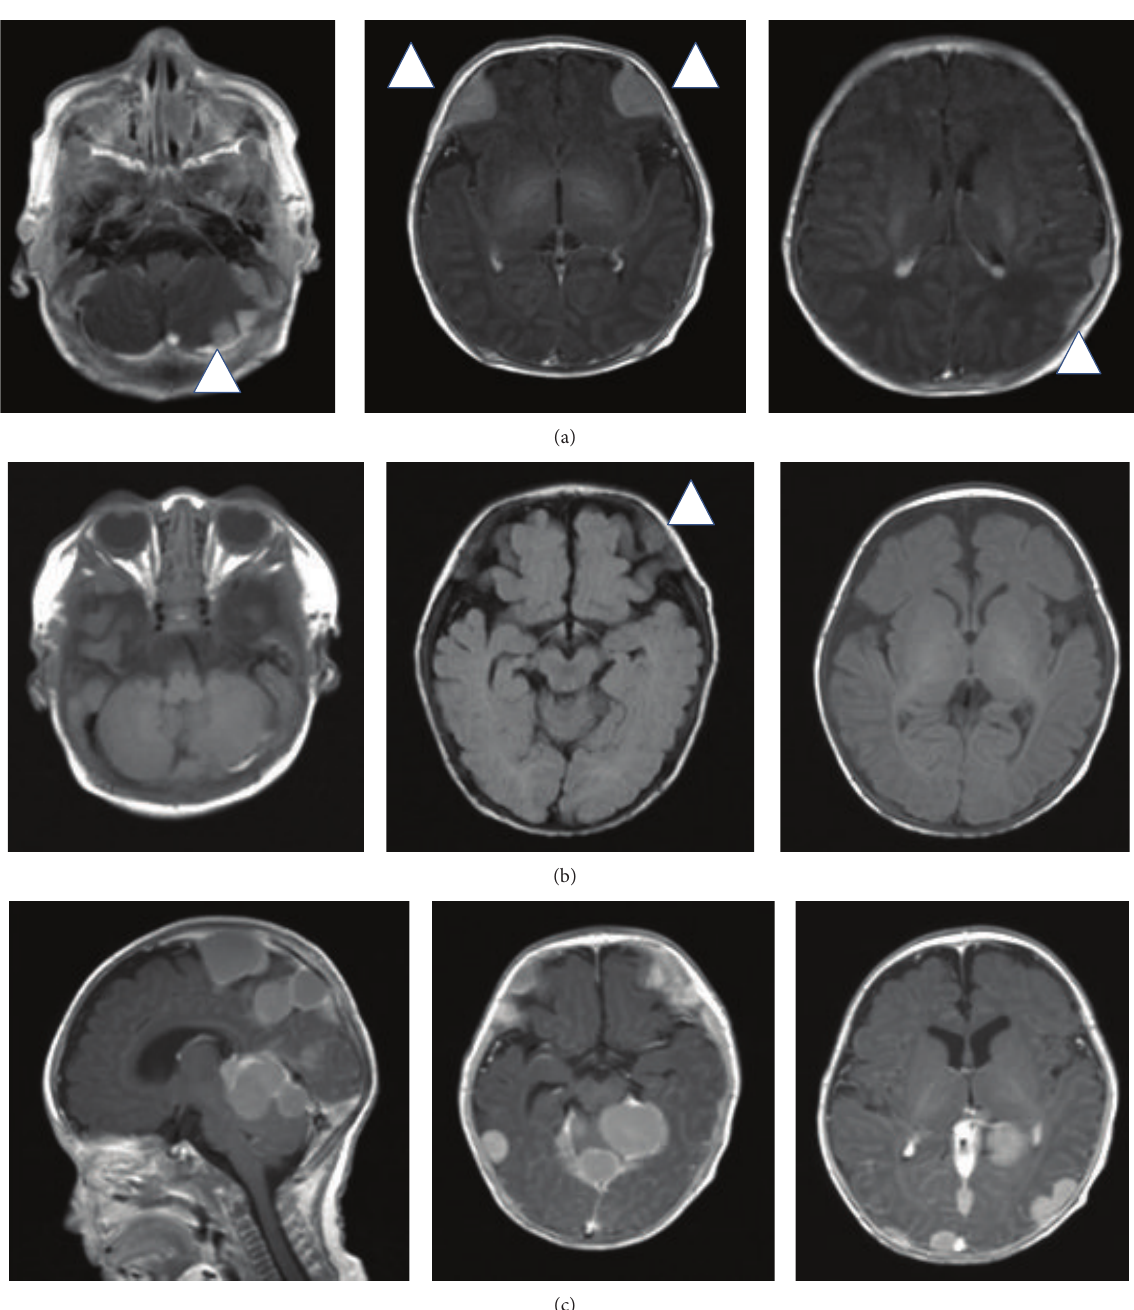
Figure 1: Magnetic resonance imaging studies of the brain: (a) a gadolinium-enhanced T1-weighted image at 7 days of age, (b) a T1-weighted image at 45 days of age, and (c) a gadolinium-enhanced T1-weighted image at 72 days of